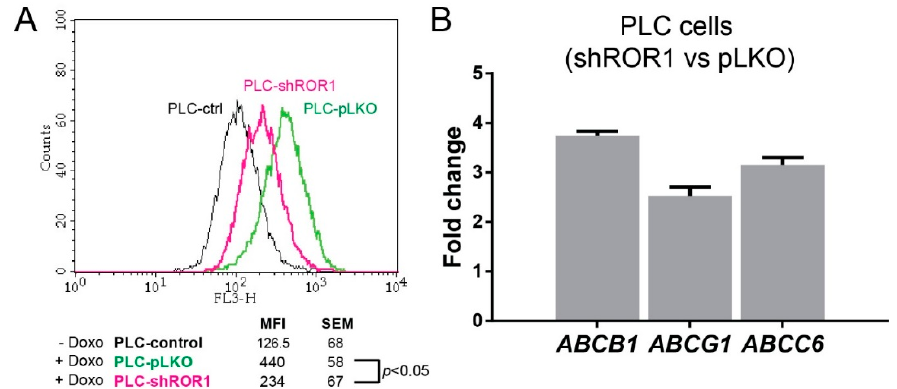
Figure 7. Analysis of drug resistance of shRNA ROR1-knockdown and control clones. ( A ) Drug efflux capacities of shRNA ROR1-knockdown and control clones: Cells were treated with 0.5 µ g/mL Doxorubicin for 1 h and mean fluorescence intensities (MFI) were measured with flow cytometry after 4 h. SD: standard deviation. ( B ) Expression of ABC genes in mRNA levels were analyzed in shRNA ROR1-knockdown clones and calibrated to control clones by RT-qPCR. Relative fold change values (log2) were normalized to GAPDH .